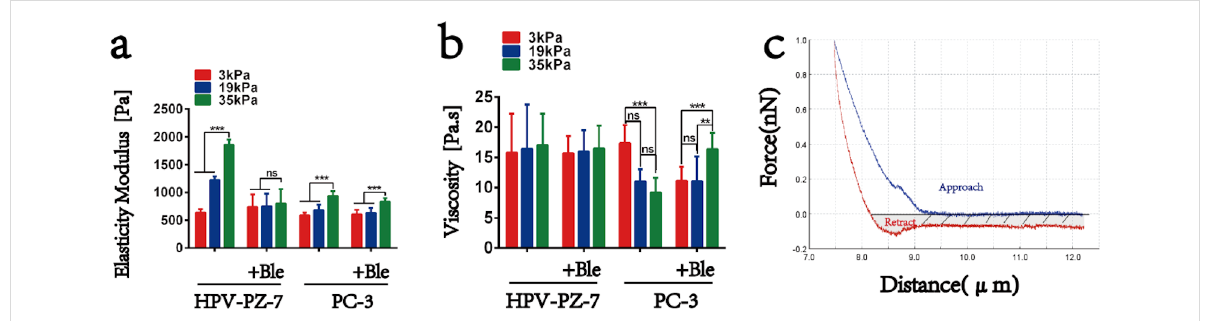
Figure 5: Mechanical properties respond to the effect of substrate stiffness on prostate cancer cells. (a) The average elasticity value of HPV-PZ-7 and PC-3 cells on substrates of different stiffness with or without blebbistatin. (b) The average viscosity value of HPV-PZ-7 and PC-3 cells on substrates of different stiffness with or without blebbistatin. (c) Force–distance graph of cells; “ns” means no difference, ** represents the value of P < 0.01, *** represents the value of P <